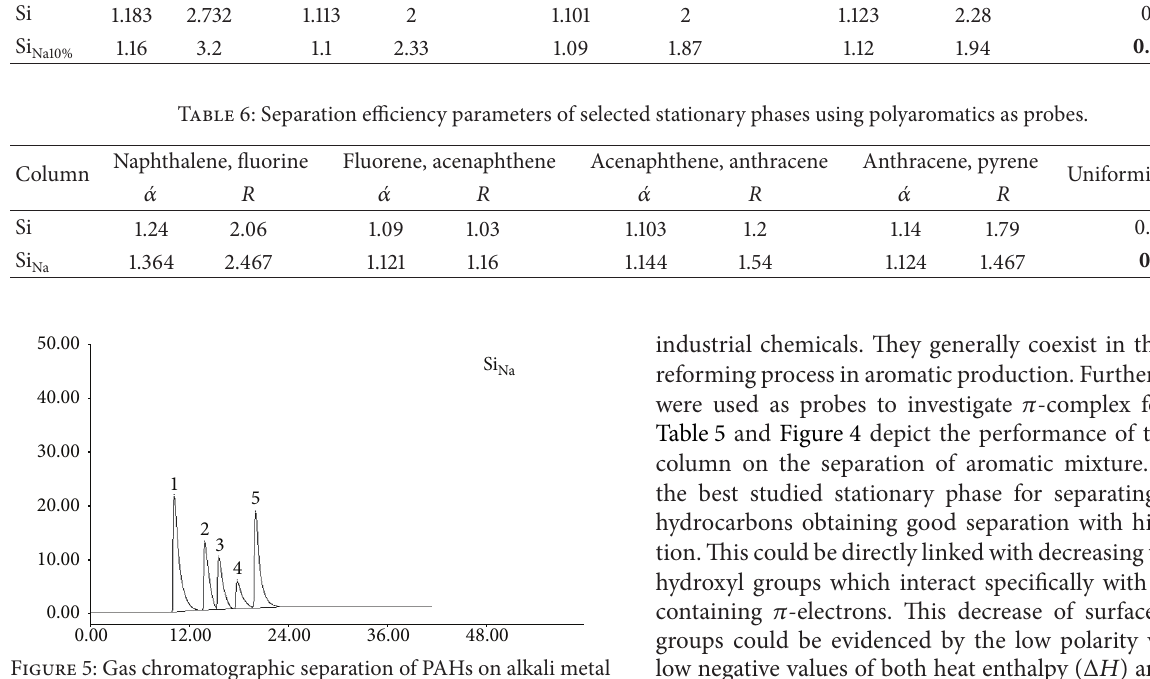
Uniformity criterion